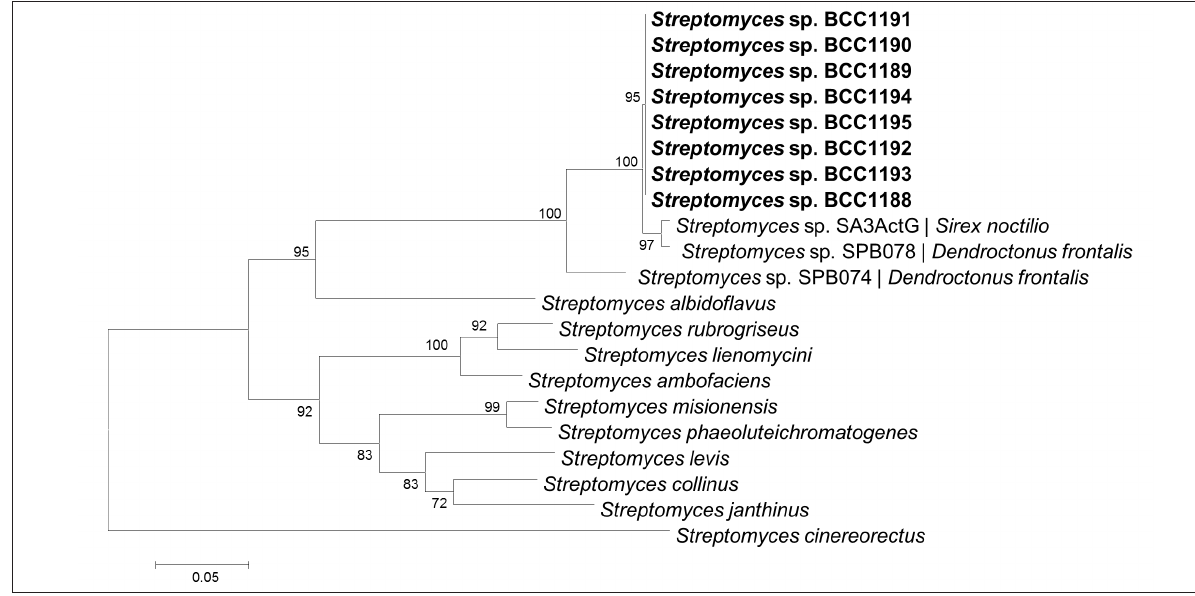
Figure 2: Maximum likelihood tree representing concatenated nucleotide sequence alignments of the gyrB , rpoB and trpB genes of nine Streptomyces type strains, eight isolates from this study (bold type) and three Streptomyces strains isolated from other pine-infesting insects, as retrieved from the